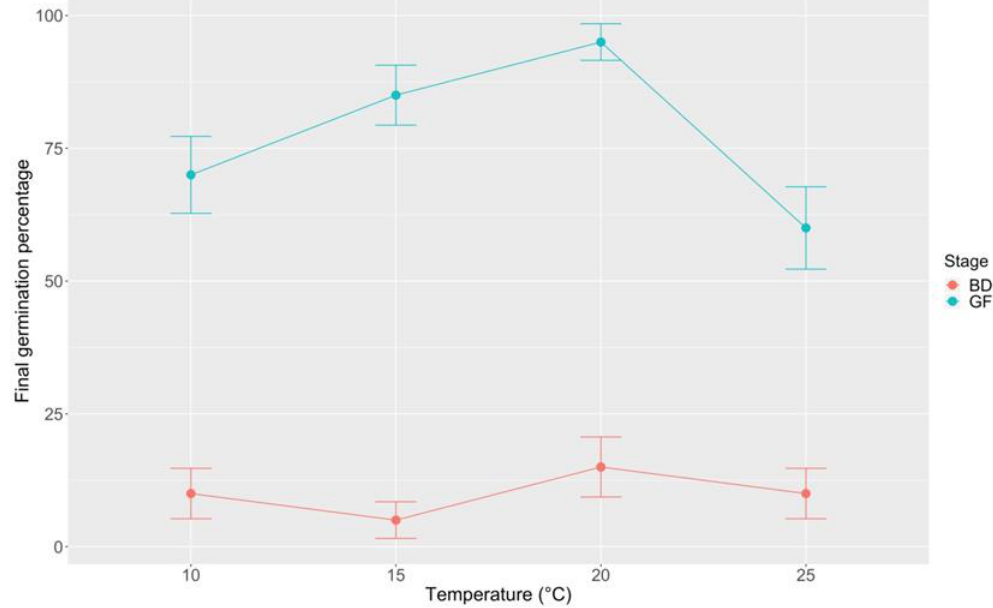
Figure 11. Final germination percentage at different incubation temperatures (10, 15, 20, 25 °C) for B. bituminosa seeds from GF and BD pods after 180 days of storage at 5 ± 1 °C. Vertical bars represent standard errors. BD = brown dehydrated; GF = green full.